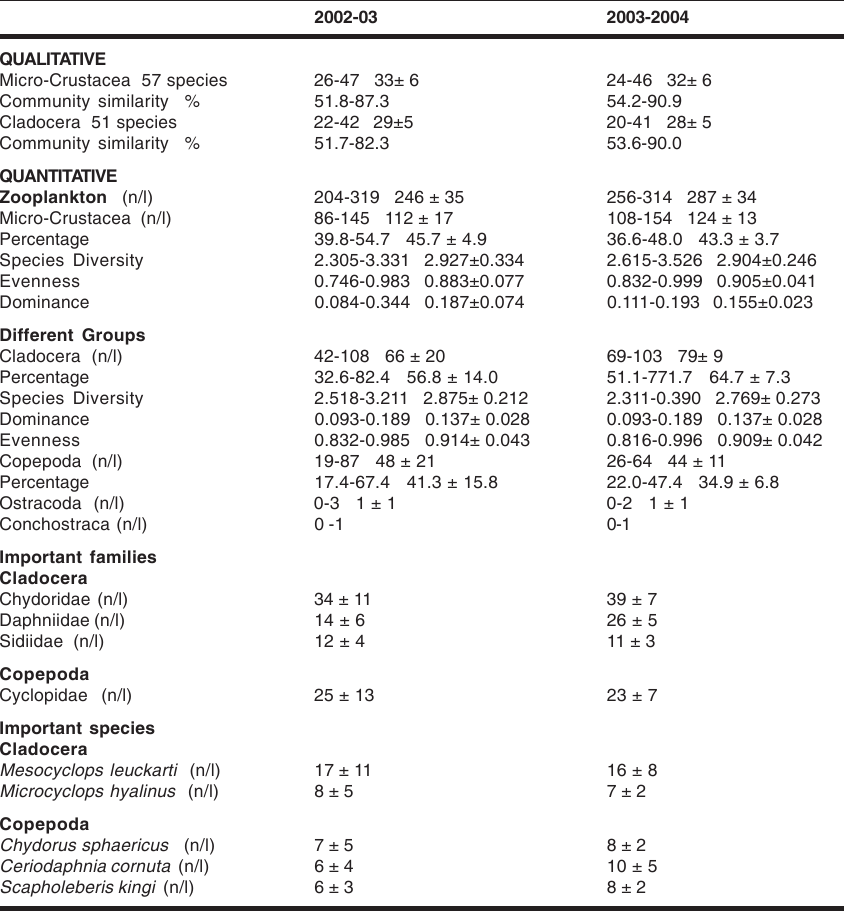
Table 2. Temporal variations of